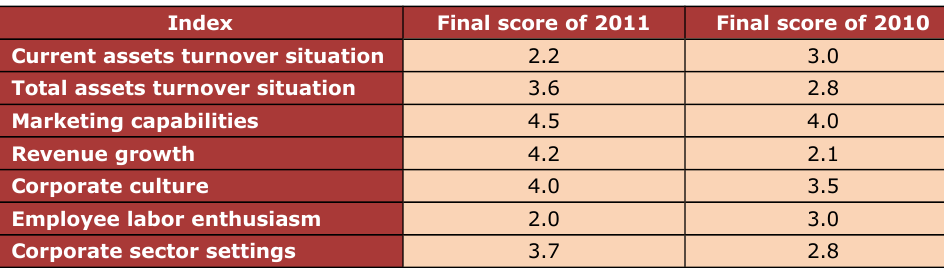
Table 3. The final indexes scores of enterprise